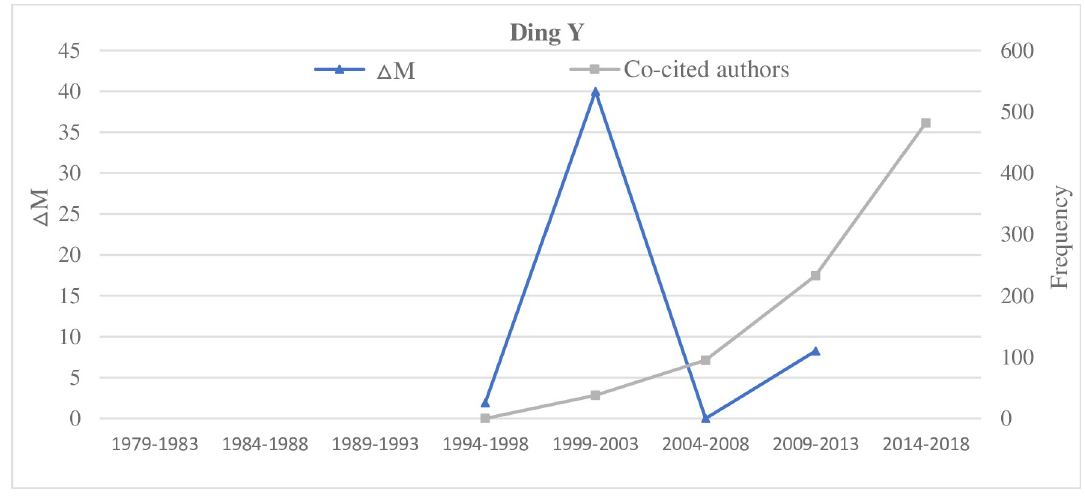
Fig 10. Indicators of the impact of Ding